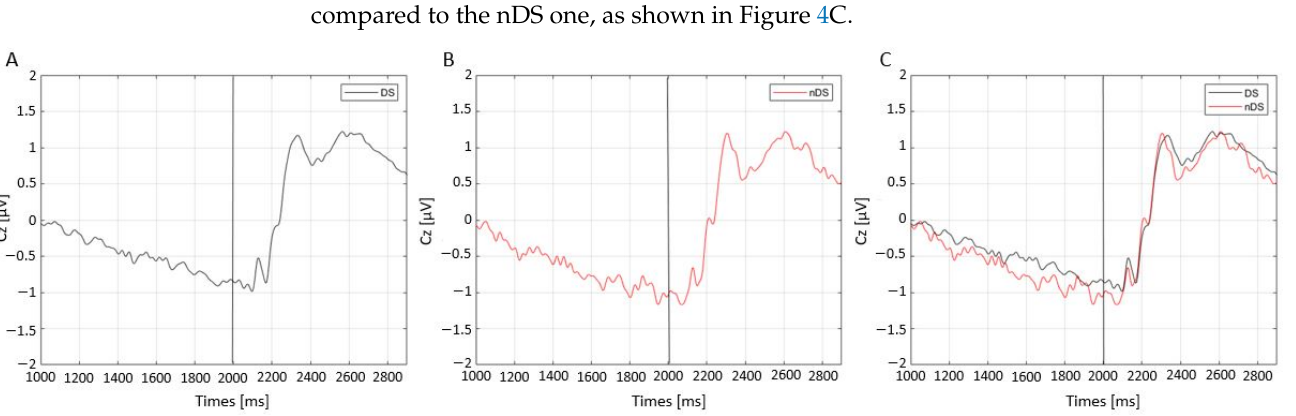
Figure 4. Contingent negative variation (CNV) trends of Cz electrodes after directional stimuli (DS) ( A ), non ‐ directional stimuli (nDS) ( B ) and their overlap ( C ).